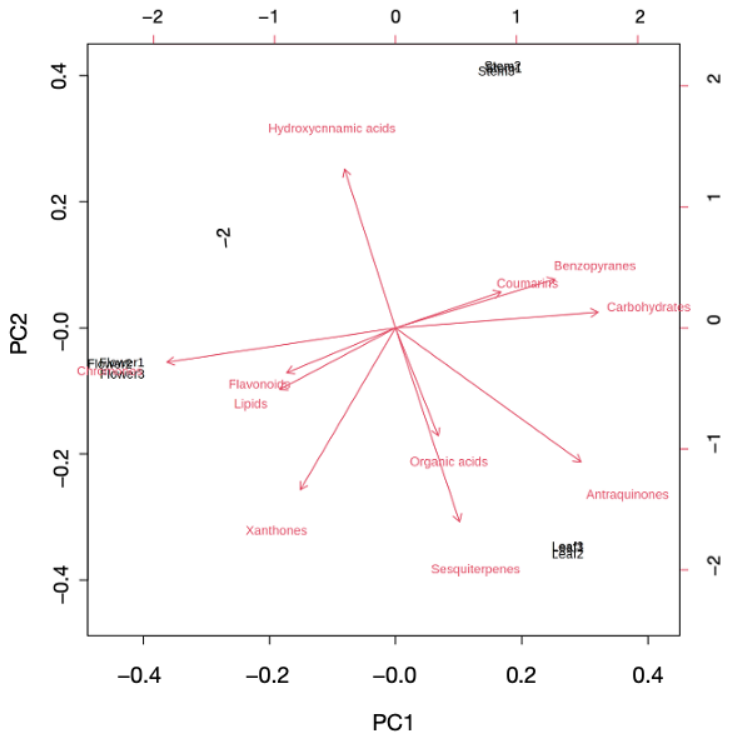
Figure 2. Biplot built using the intensities of annotated metabolites (PC1 54,3%, PC2 38.6%) grouped into the main biochemical classes. into the main biochemical